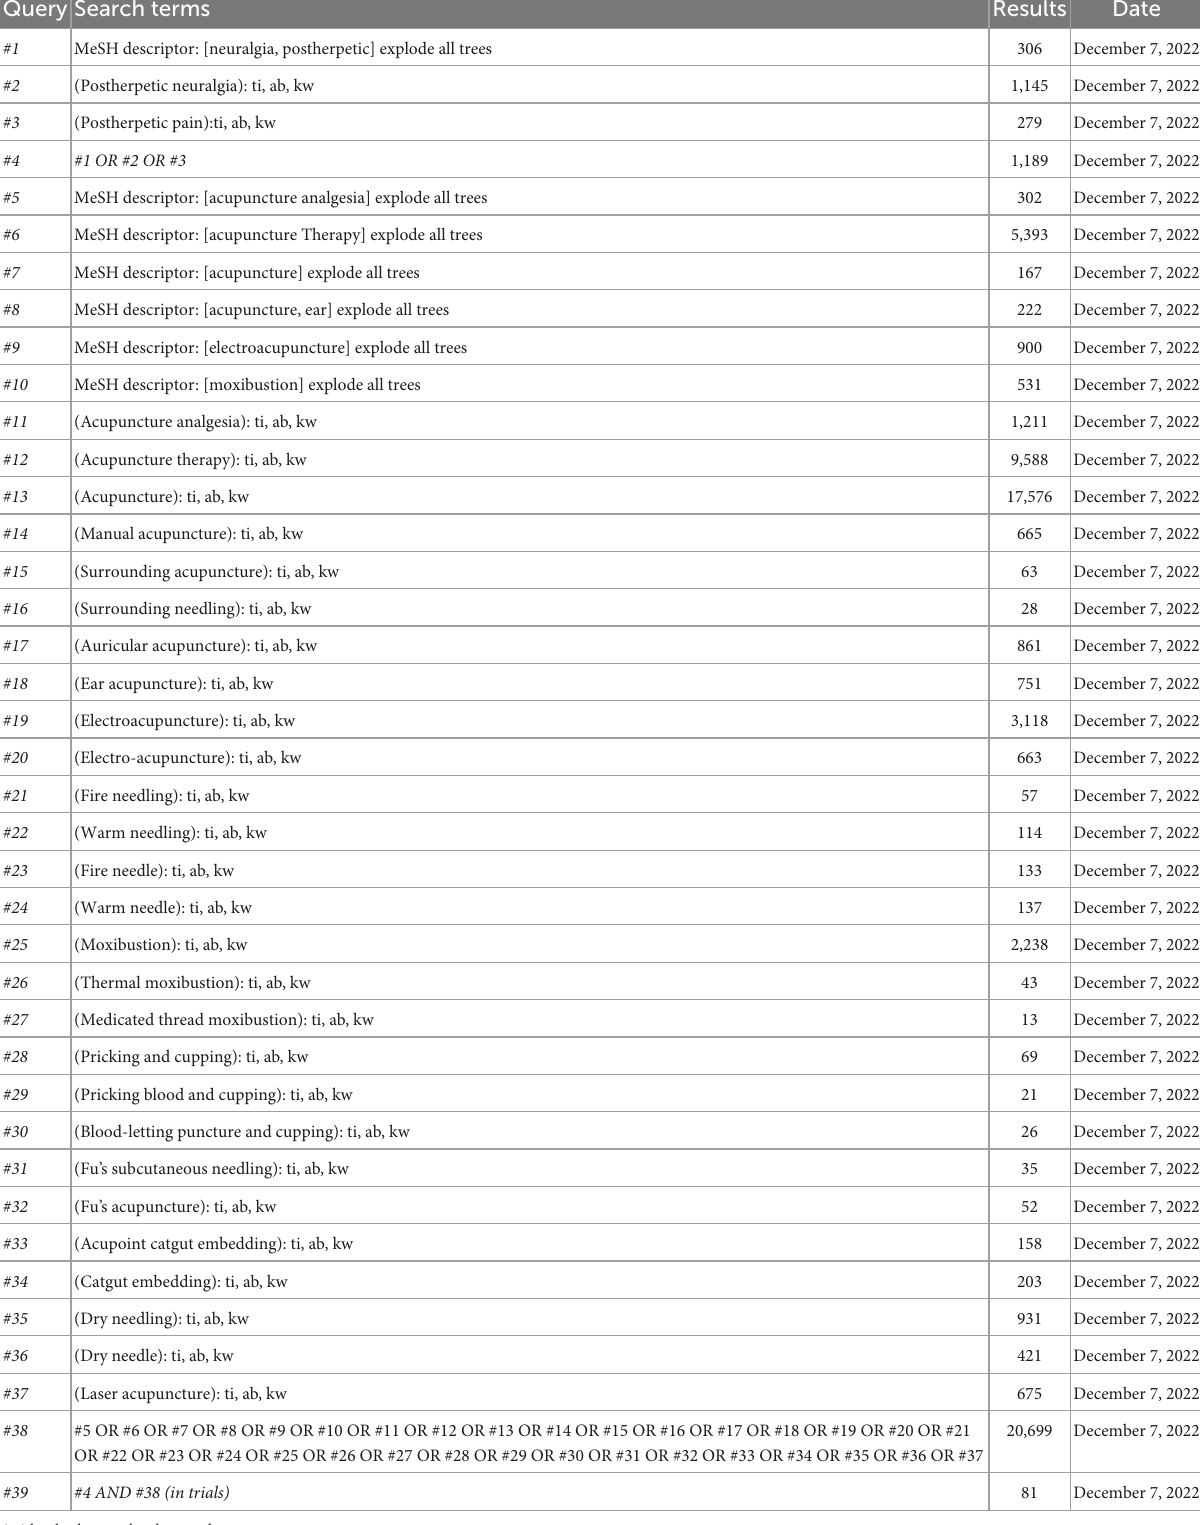
TABLE 1 CENTRAL: Search strategy. Query Search